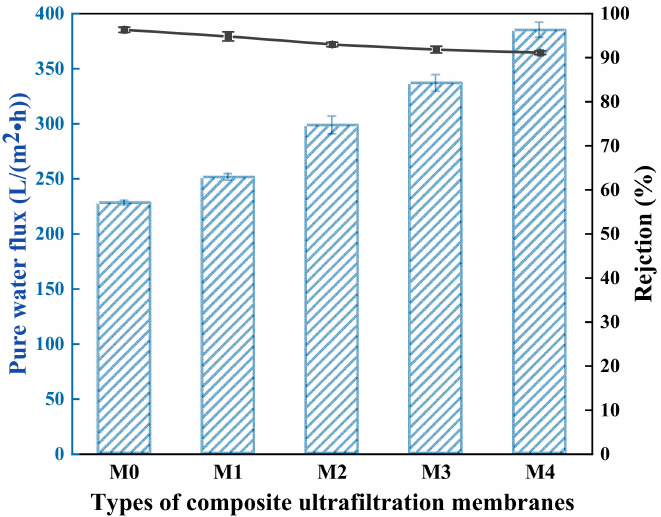
Figure 4. Pure water flux and BSA rejection for the MoS 2 -FeOOH/PES composite